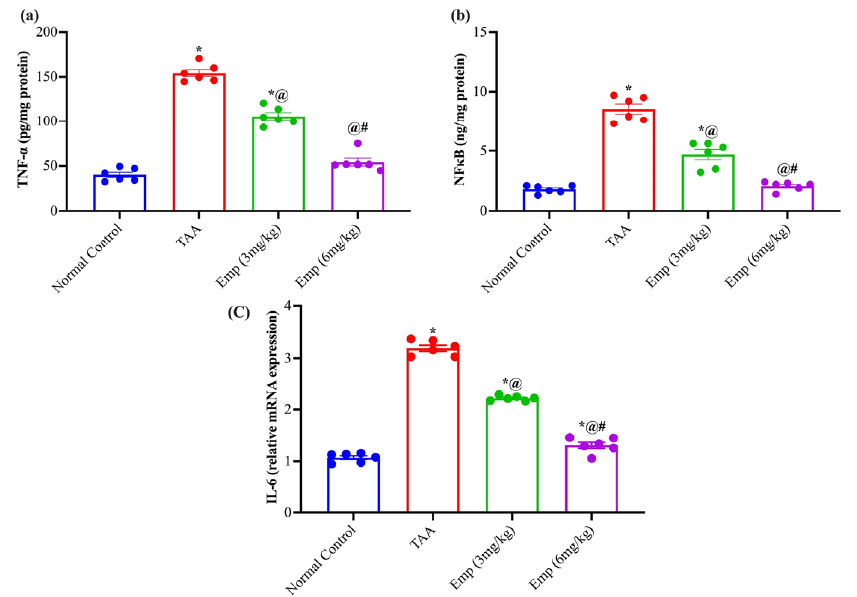
Figure 2. Effect of empagliflozin on hepatic ( a ) TNF α , ( b ) NF κ B, and ( c ) IL-6 relative expression in thioacetamide-intoxicated rats. Each bar represents as mean ± SE. * vs. normal control group, @ vs. TAA group, # vs. Emp (3 mg/kg) at p < 0.05.